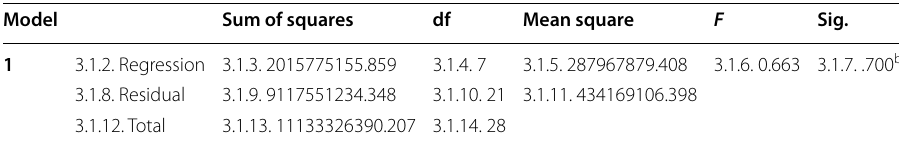
Table 9 Analysis of variance (ANOVA) for factor 2 variables Model